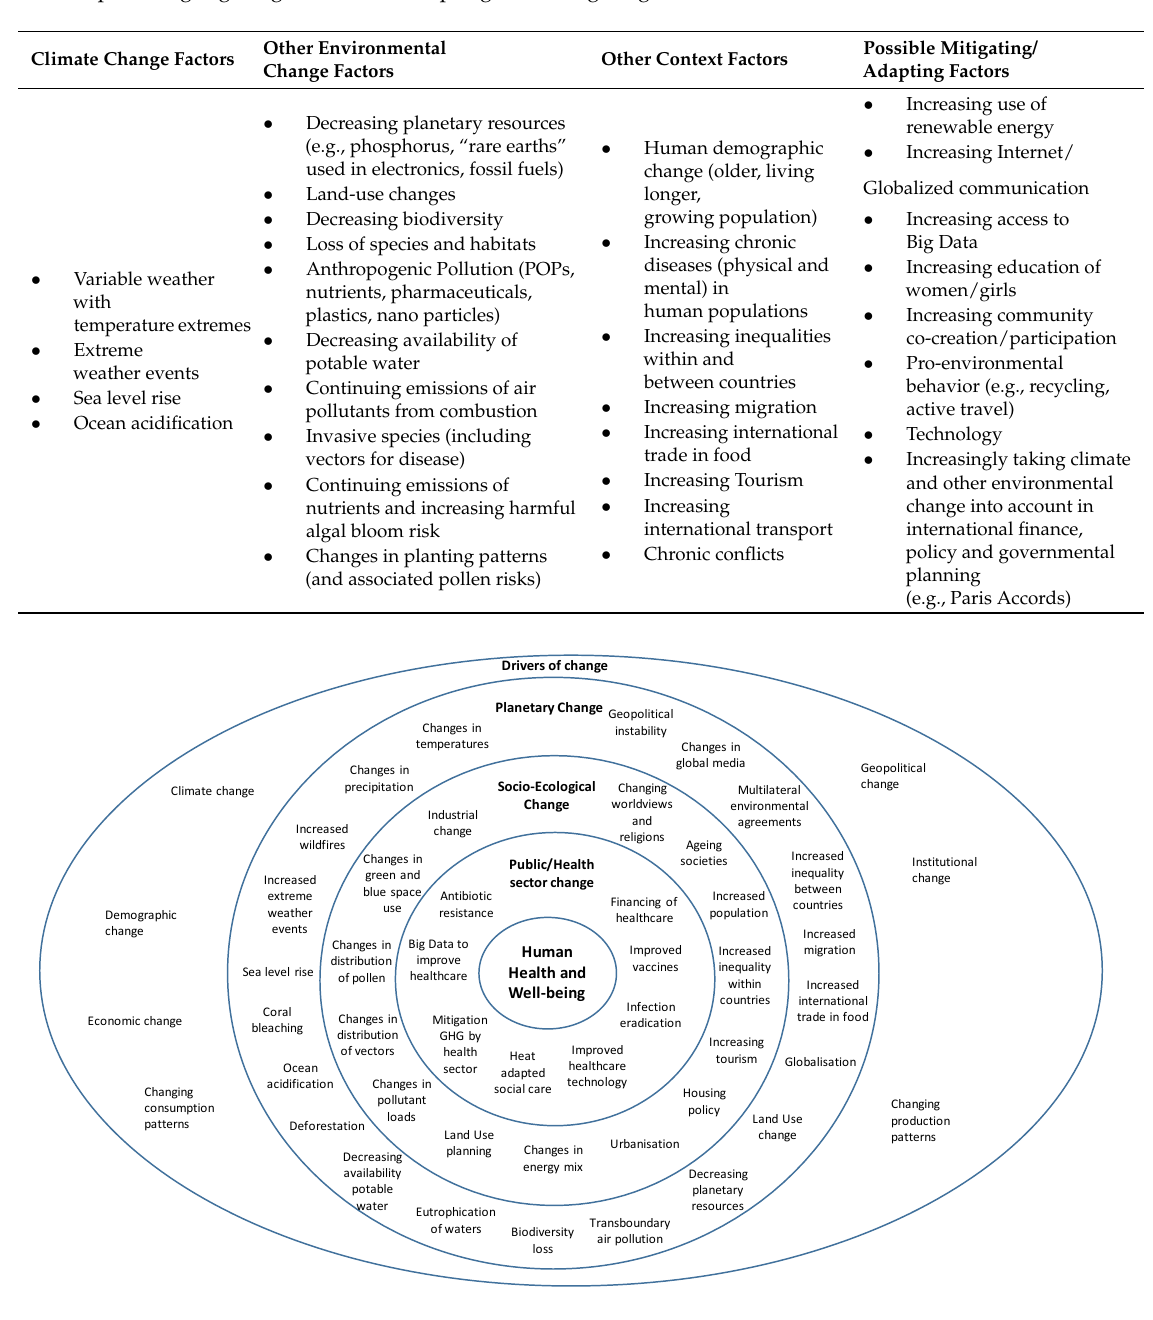
Table 1. Climate and other environmental changes with potential for large scale population health impacts, highlighting contextual, adapting, and mitigating factors.